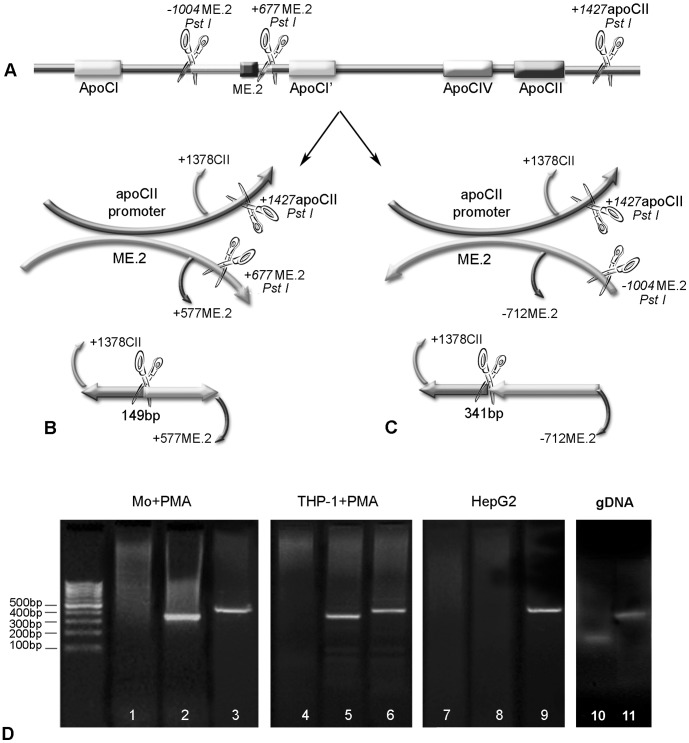
Interactions between apoCII promoter and ME.2 in macrophages as revealed by chromosome conformation capture (3C) assays.
Panels A–C. Schematic illustration of the linear alignment of ME.2 and apoCII (including the Pst I sites adjacent to these regions) and the possible interactions between apoCII promoter and ME.2 in sense (B) or antisense (C) orientation. For 3C experiments, the PstI restriction enzyme was used. PstI restriction sites are located at positions +1427 in apoCII gene as well as at +677 bp downstream of ME.2 and at −1004 bp upstream of ME.2, as showed in the picture. The primers flanking the newly ligated fragments are also illustrated: for both cases (B and C), the forward primer was +1378CII, and the reverse primers were: +577ME.2 (B) and −712ME.2 (C). The predicted lengths of the ligated fragments are: 149 bp for “sense orientation” (B) and 341 bp and “antisense orientation” interaction with ME.2 (C). Panel D. Human peripheral blood monocytes (lanes 1–3) and THP-1 cells (lanes 4–6) differentiated to macrophages by PMA treatment, as well as HepG2 cells (lanes 7–9), were subjected to the 3C assay. PCR fragments amplified with primers +1378CII and +577ME.2 (testing the interaction in sense orientation) are shown in lanes 1, 4 and 7, and PCR products obtained with primers +1378CII and −712ME.2 (testing the interaction in antisense orientation) are shown in lanes 2, 5 and, respectively 8. The positive control for DNA integrity and PCR (amplification of a 468 bp fragment of ME.2) are shown in lanes 3, 6 and respectively 9. ME.2 and the apoCII promoter interact in antisense orientation since only the fragment of 341 bp was obtained from human monocytes and THP-1 cells differentiated with PMA (lane 2 and, respectively 5) whereas no bands were obtained for sense orientation interaction (lanes 1 and, respectively 4). In contrast, in HepG2 cells, 3C experiments gave no bands either for sense or antisense orientation interaction (lanes 7 and, respectively 8), revealing that apoCII promoter and ME.2 do not interact in hepatocytes. As control, genomic DNA isolated from THP-1 cells was used, and the amplification of the ligation products using +1378CII and +577ME.2 primers, and +1378CII and −712ME.2 primers, gave the expected size of the PCR products of 149 bp and 341 bp (Fig. 2D, lanes 10 and 11, respectively).